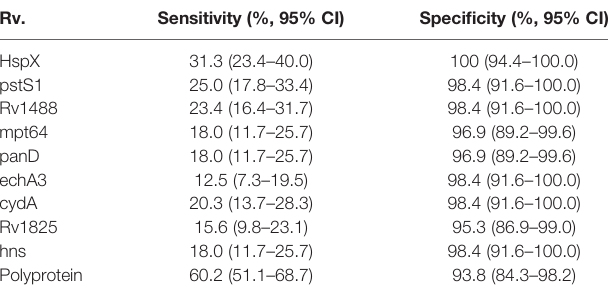
TABLE 5 | Sensitivities and speci fi cities of nine individual antigens (or segments) and the fusion polyprotein with sera from TB patients and healthy controls.